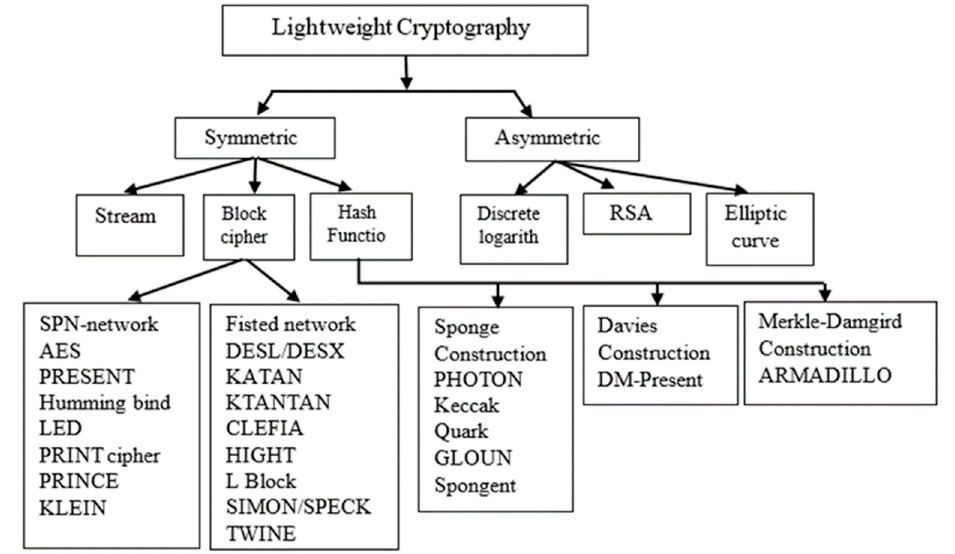
Figure 1. Lightweight cryptography (LWC) diagram.